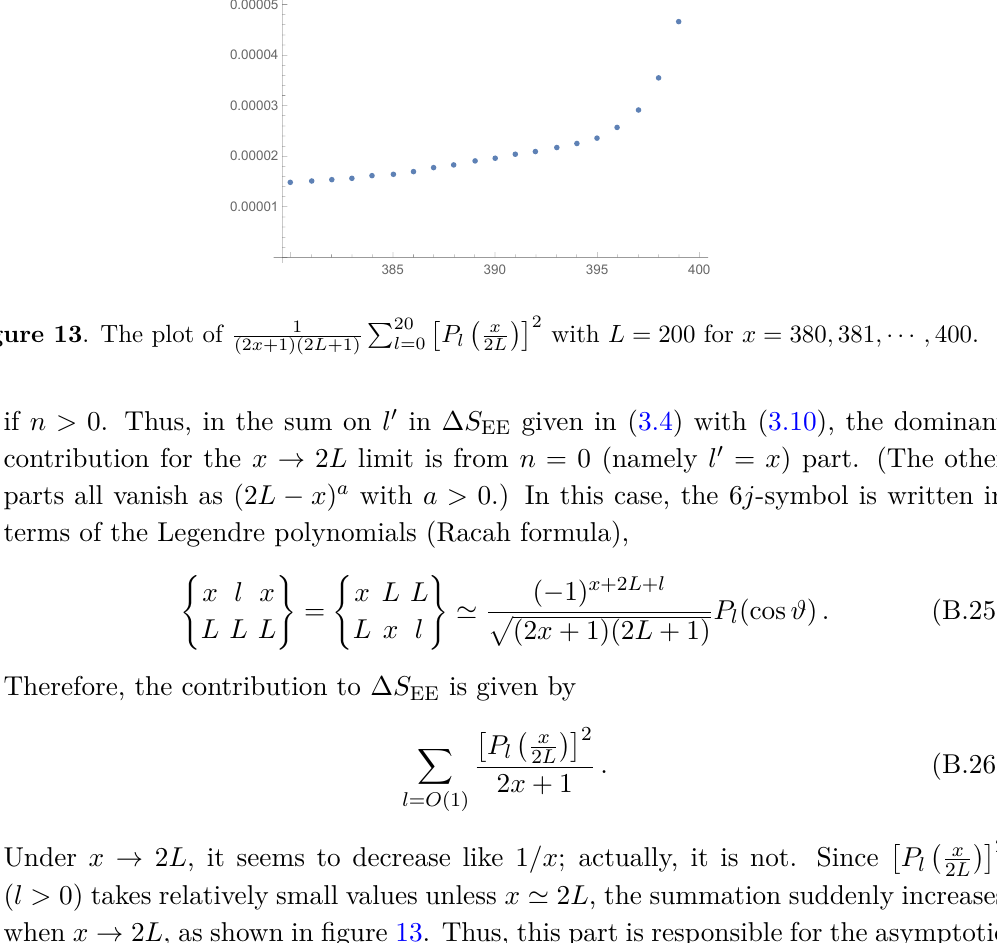
(cid:2) (cid:0) x (cid:1)(cid:3) 2 with P 20 P l L = 200 for x = 380 , 381 , · · · , 400 l =0 2 L